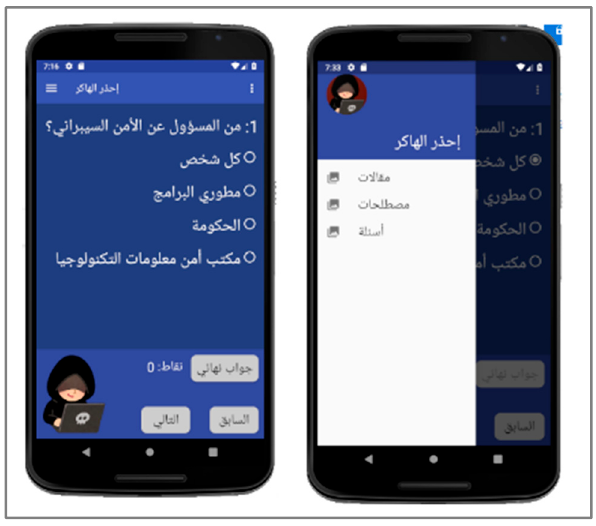
Figure 9. The Question View and the side menu of the “Be Aware of the Hacker”